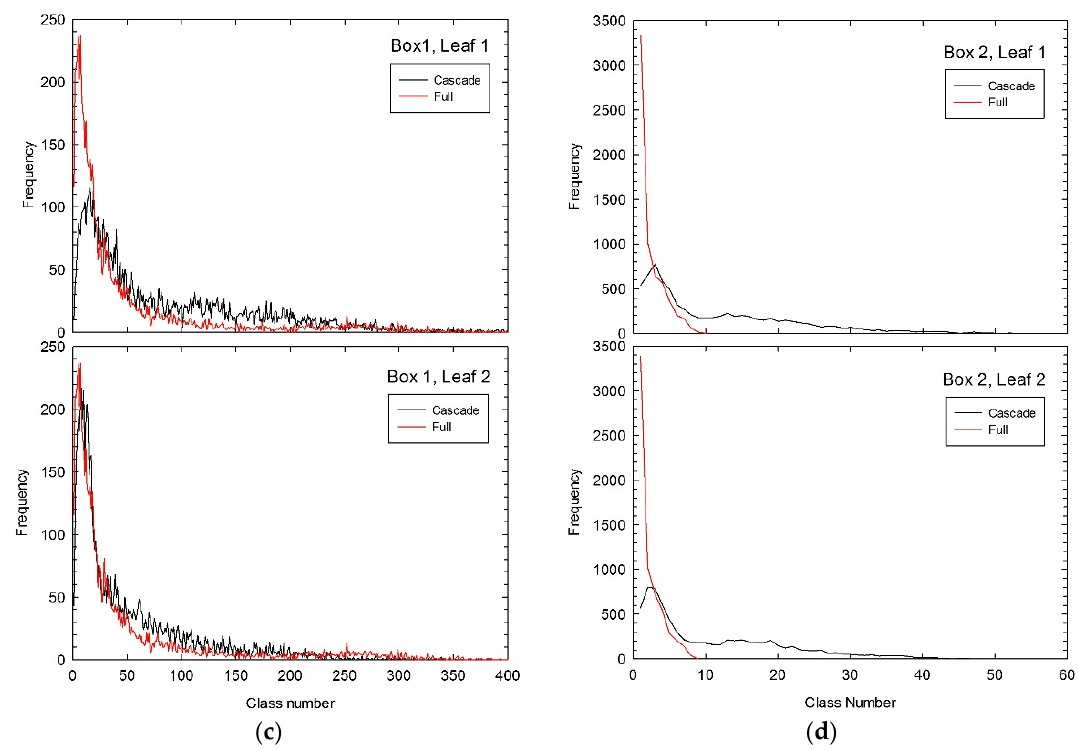
Figure 12. Computed wall shear stress maps on the leaf spring surfaces for the first carousel position in the original quench system using ( a ) “cascade” and ( b ) full system methods. Comparison of wall shear stress cell frequency for ( c ) first carousel position, box 1 and ( d ) second carousel position, box 2. One class number is equivalent to 0.01 Pa.